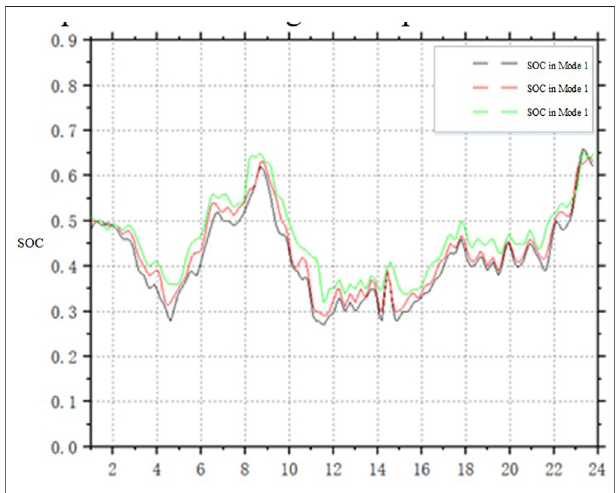
FIGURE 6 | The SOC change diagram in Mode 1, 2, and